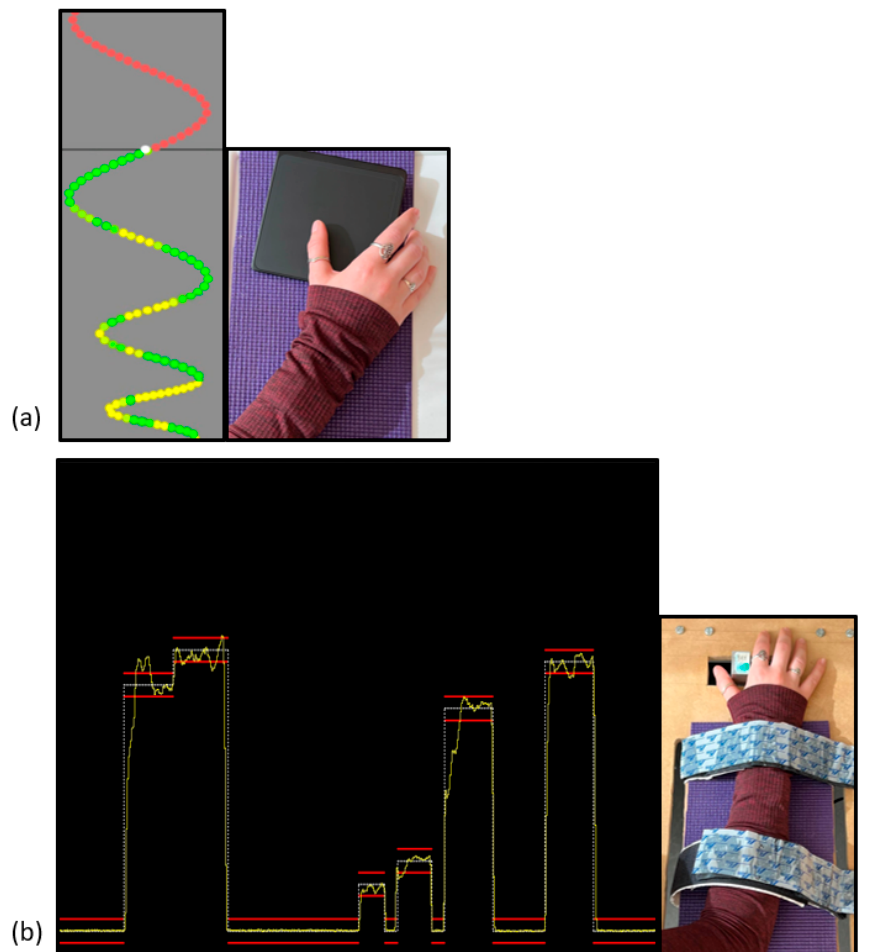
Figure 1. Depiction of each motor paradigm. ( a ) Visuomotor tracing task (MTT) and ( b ) force- matching task (FMT). Each task was completed using the right hand and thumb, while visual feedback was presented to the